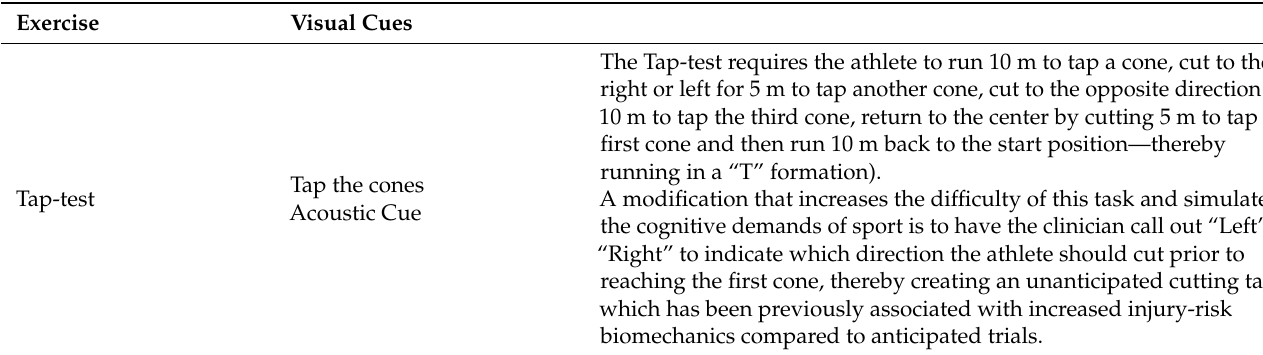
Table 3. Visual-motor training exercises